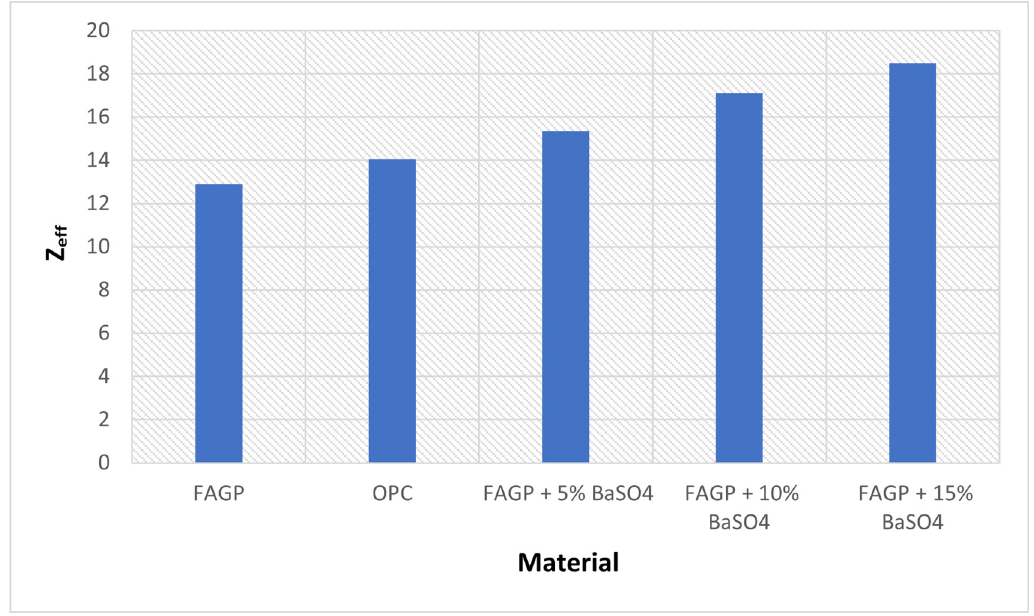
Figure 3. Histogram plot of Z eff values for OPC and FAGP with different concentration of BaSO 4 .